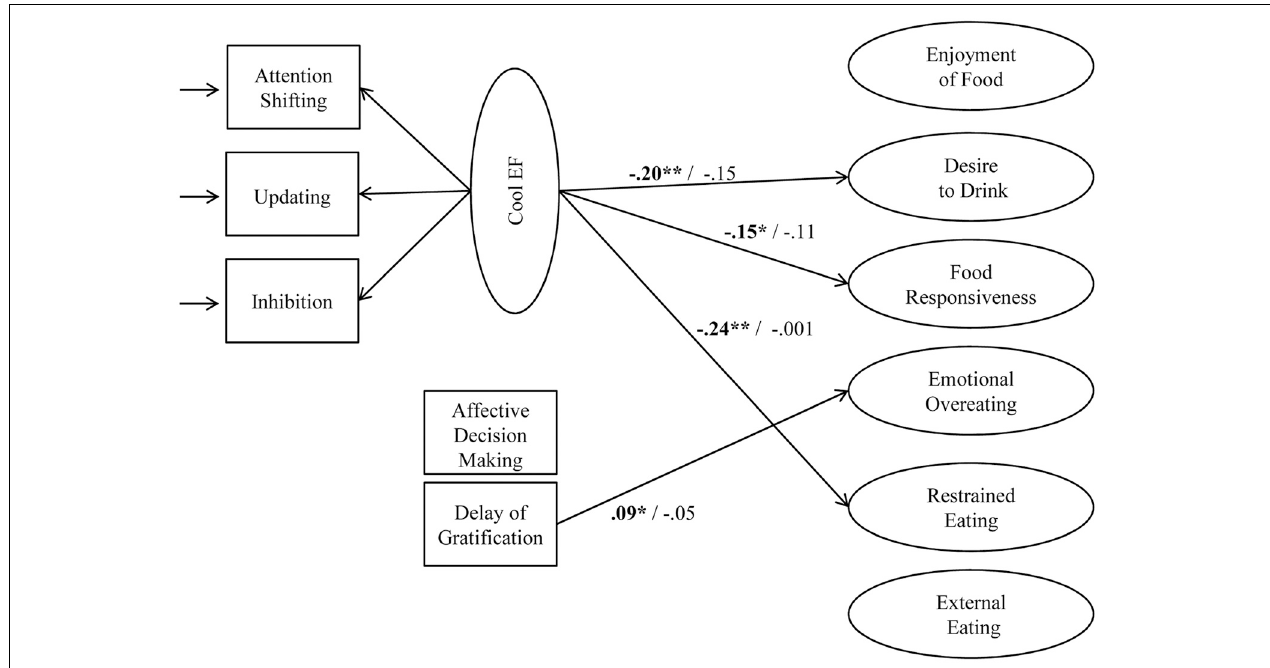
FIGURE 4 | Associations of the latent cool EF factor and the two hot EF tasks with latent food approach scales. Results are controlled for age and fluid intelligence. Results of girls are highlighted in bold, results of boys are shown in regular font. ∗ p ≤ 0 . 05; ∗∗ p ≤ 0 . 01.